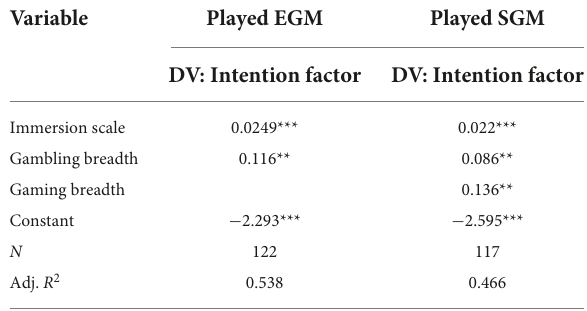
TABLE 3 Results of stepwise OLS regression predicting intention to